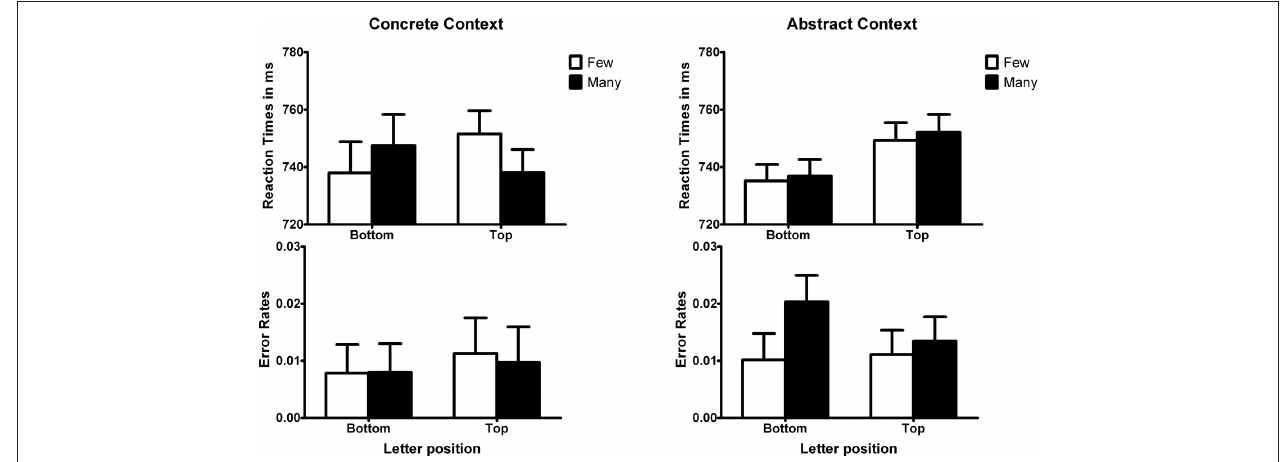
Figure 2 | reaction times and error rates for the letter identification task in experiment 3. Error bars represent standard error of the mean difference for adjacent